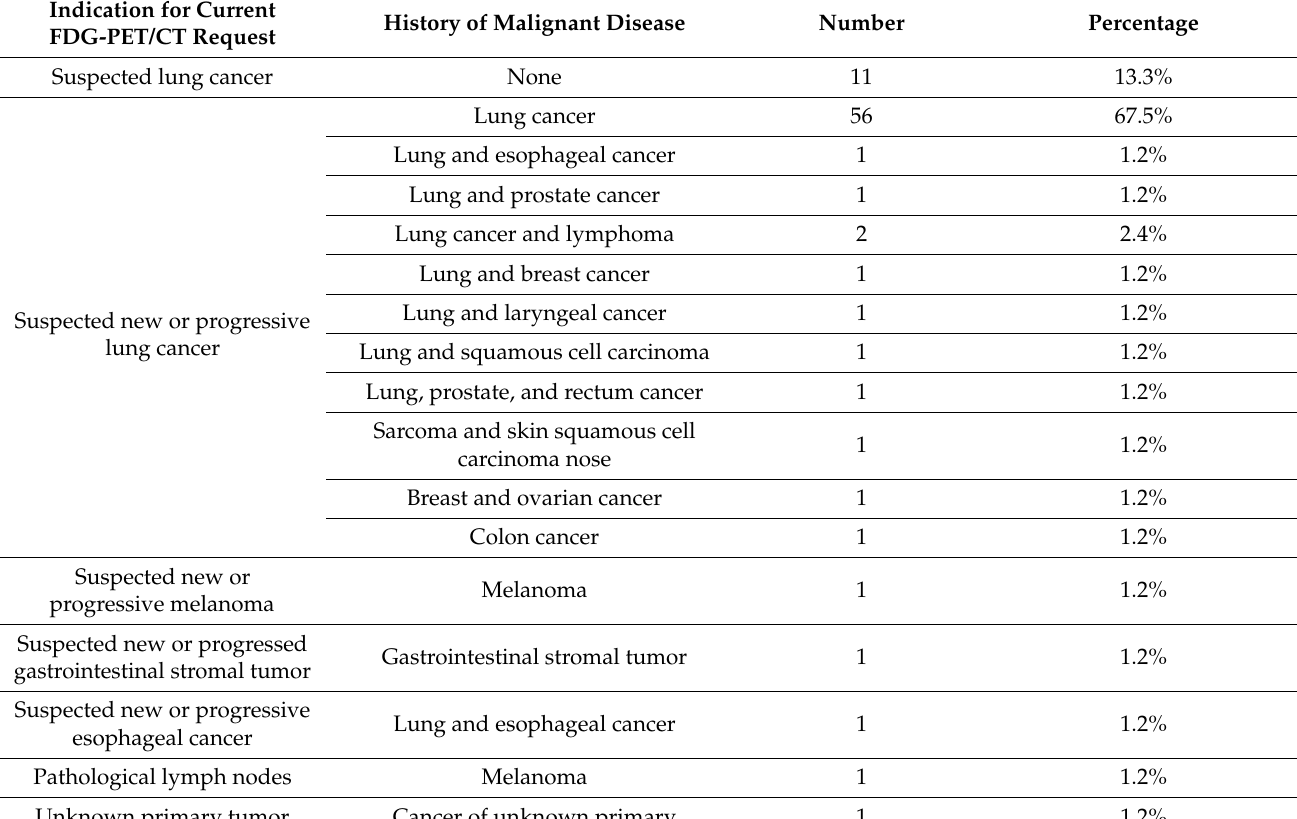
Table 1. Indication for FDG-PET/CT scanning per patient